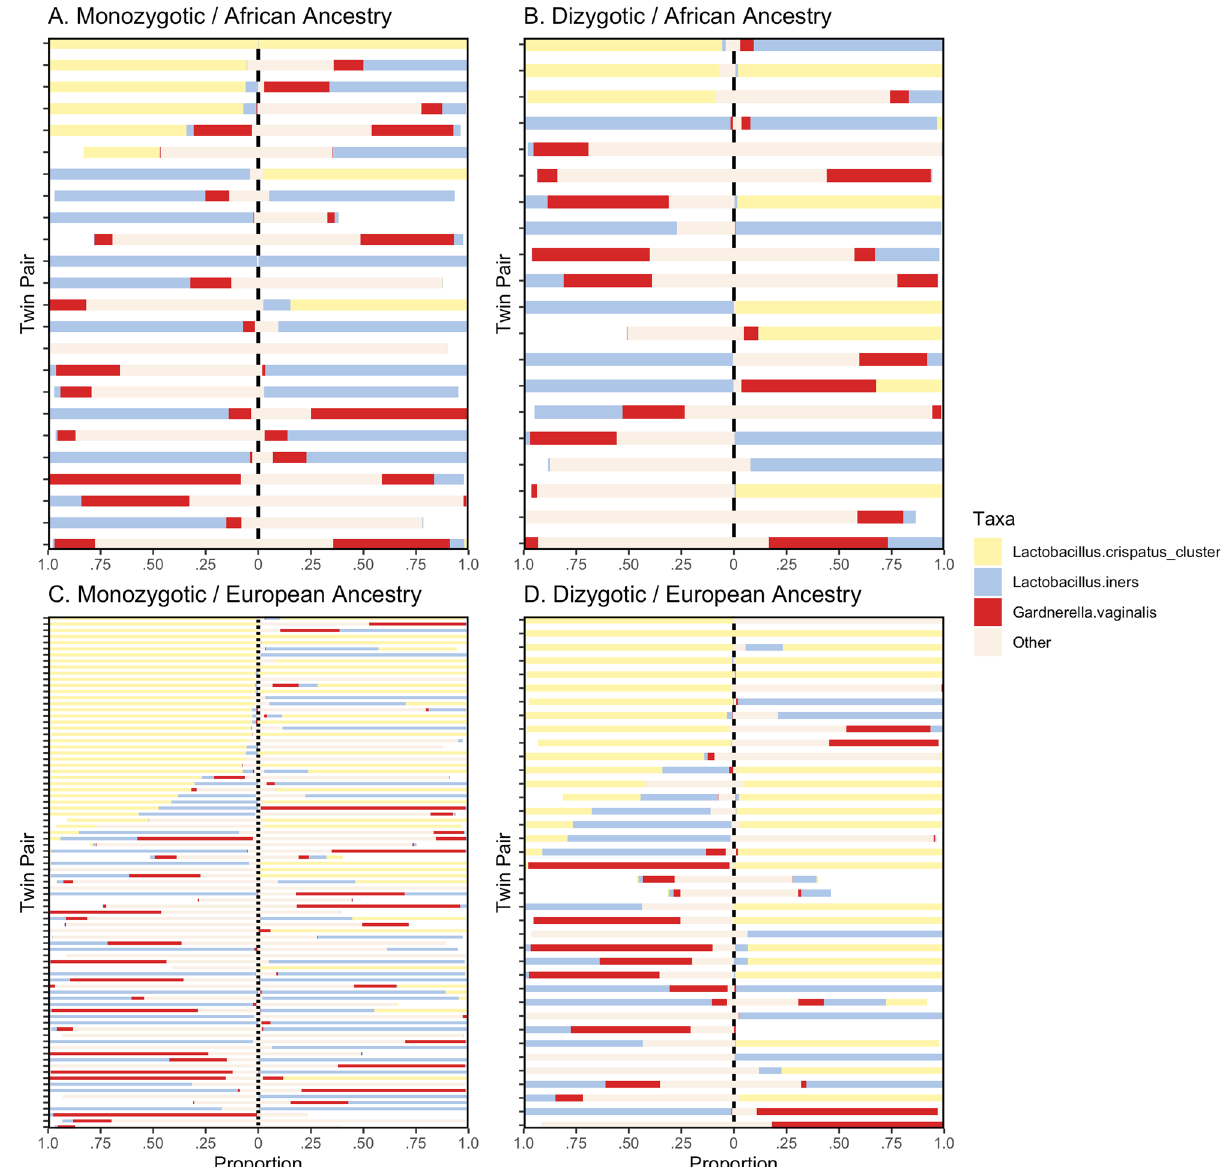
Fig. 1 Taxa distribution across zygosity and ancestry. Twin pairs are represented as one horizontal line within a pane with each member separated by the vertical dashed line. Monozygotic twin pairs are presented in the left panels, with dizygotic twin pairs on the right. The upper panels are twin pairs of African ancestry, and European ancestry twin pairs are the bottom two panels. Panels summarize taxa proportions for A . Monozygotic/African ancestry; B . Dizygotic/African ancestry; C . Monozygotic/Eurpean ancestry and; D . Dizygotic/European ancestry twin